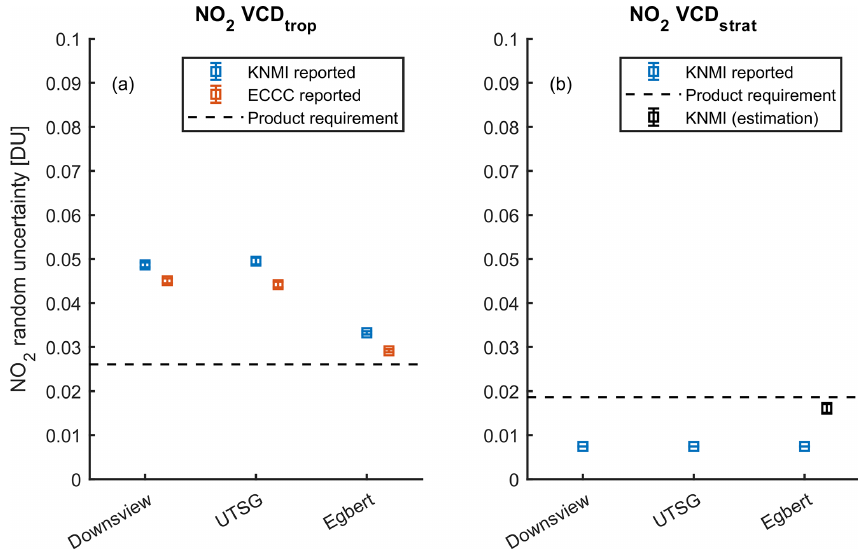
Figure C1. TROPOMI-reported random uncertainties of (a) tropospheric and (b) stratospheric NO 2 columns. Blue squares are KNMI- reported random uncertainties, with error bars from the uncertainty of the mean. Red squares are ECCC-reported random uncertainties. The black dash lines are the design requirements. The black square represents the estimated uncertainty of KNMI stratospheric